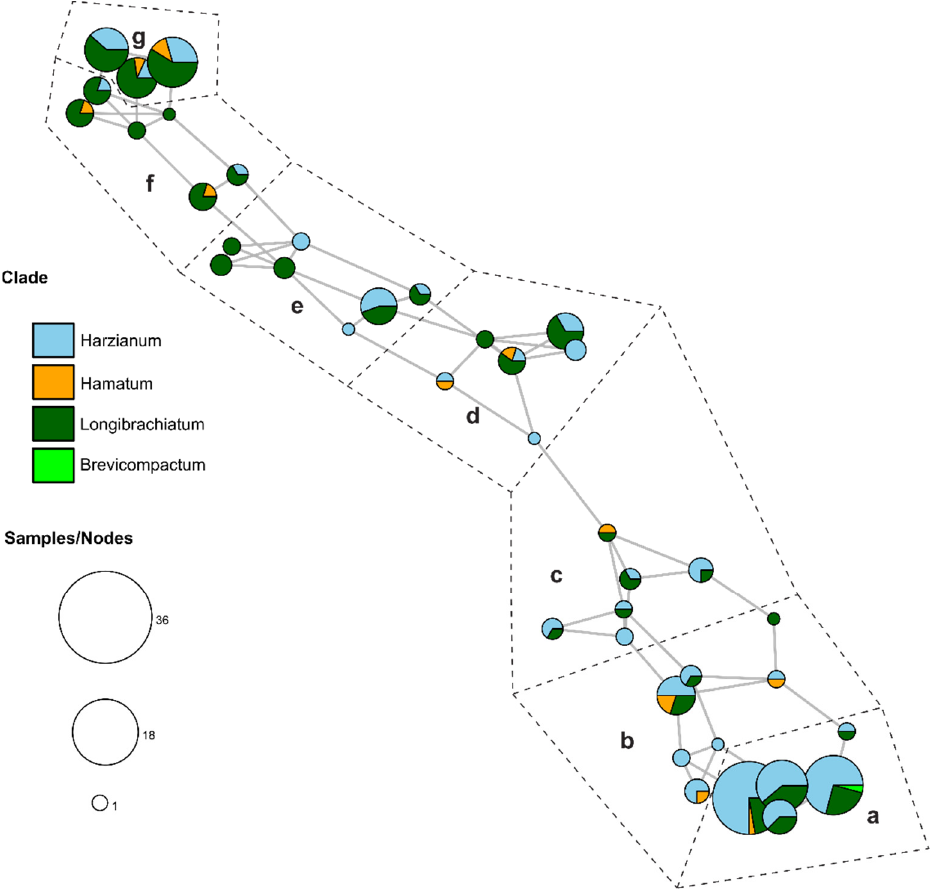
Figure 5. Minimum spanning network analysis of Trichoderma strains based on the mycoparasitism, antibiosis, and potential antagonism levels data. Nodes (circles) represent one single strain or mul- tiple strains belonging to the exact same Scott Knott groups (Tables S2 and S3) for mycoparasitism, antibiosis, and potential antagonism combined. Node size indicates the number of samples, colors indicate the phylogenetic clades to which strains belong to, and connecting lines indicate the relat- edness of strains (line lengths are arbitrary). Nodes are also framed with broken lines based on the potential antagonism Scott Knott group (“a–g”) to which strains belong to.